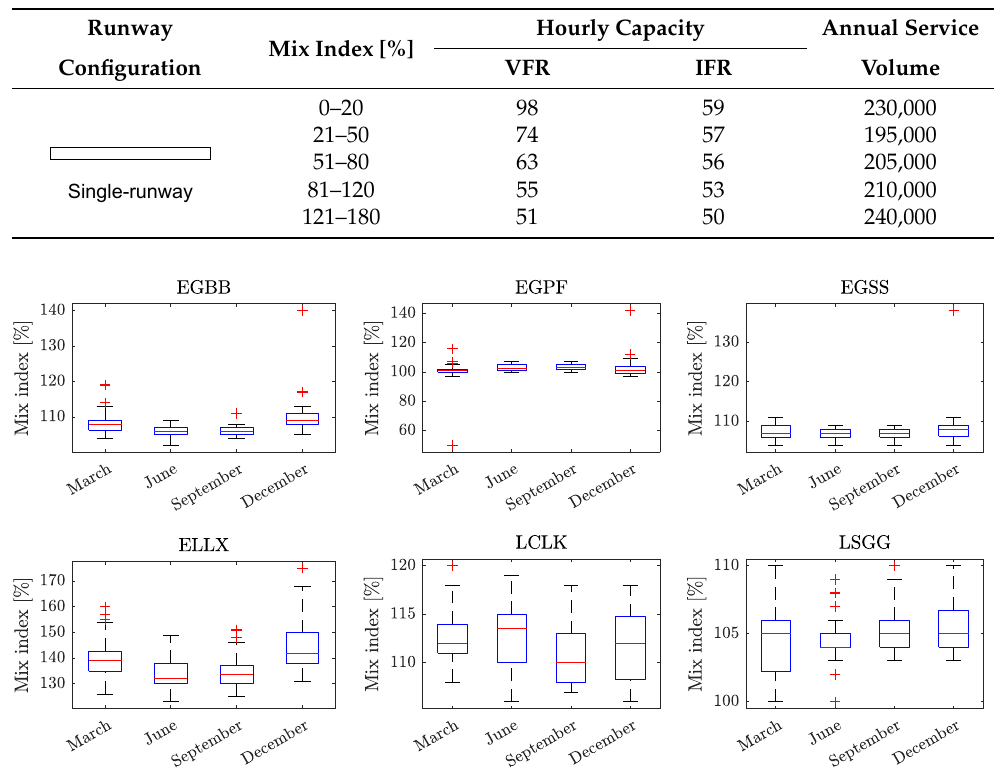
Figure 6. Seasonal distribution of the aircraft mix index for six selected airports: results computed based on the total number of flight movements per day along the months of March, June, September and December of